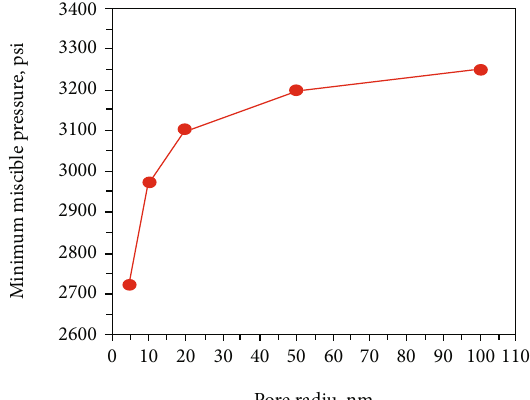
Figure 9: Minimum miscible pressure of the Bakken tight oil versus pore size.